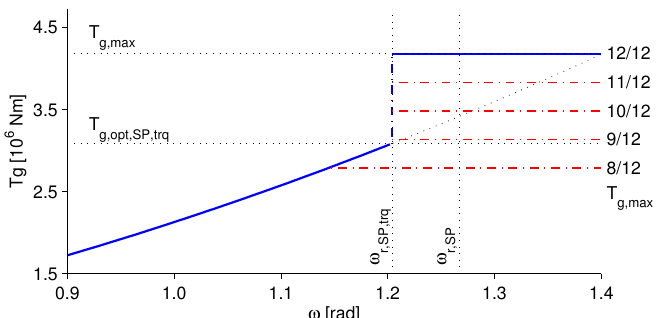
Figure 5. Regions of control and demanded generator torque dependent upon number of k = 0,1,...,4 faulty generators.